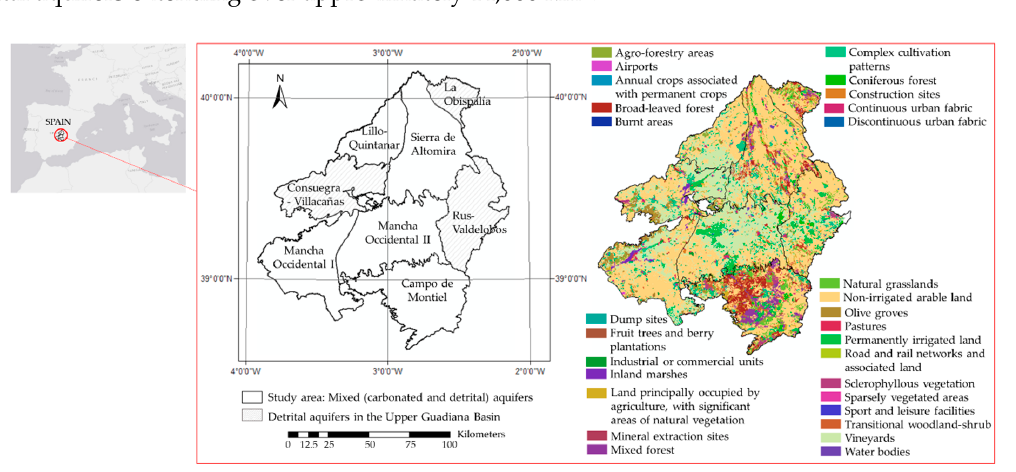
Figure 1. Location of study area within the Upper Guadiana Basin (Spain).